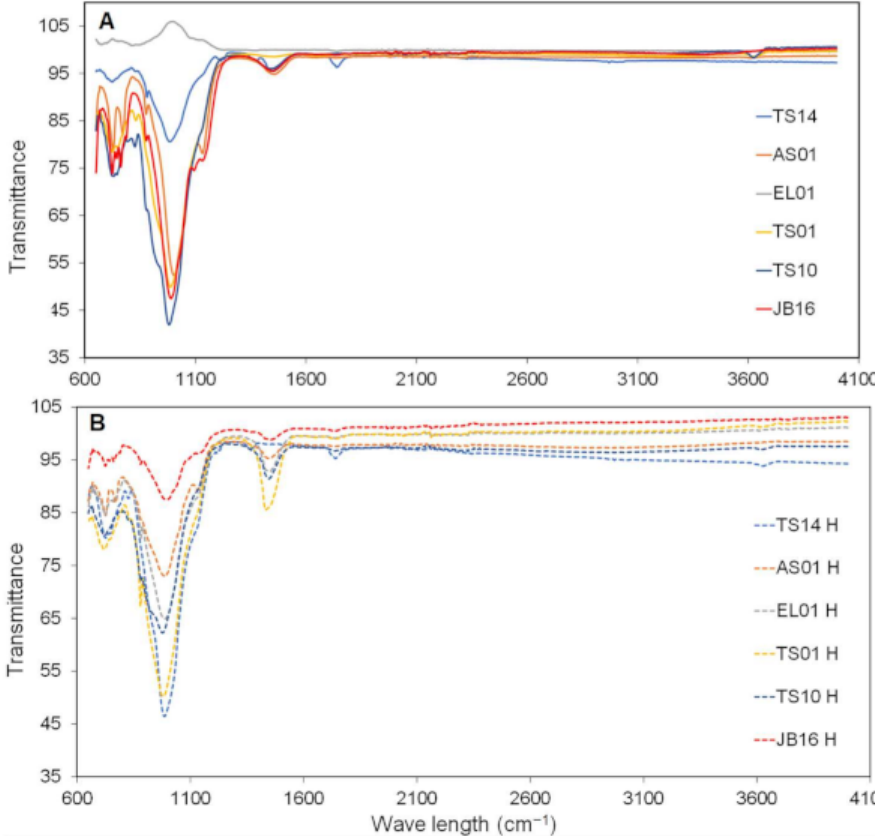
Figure 10. FTIR spectrum of raw ( A ) and hydrothermal ( B )